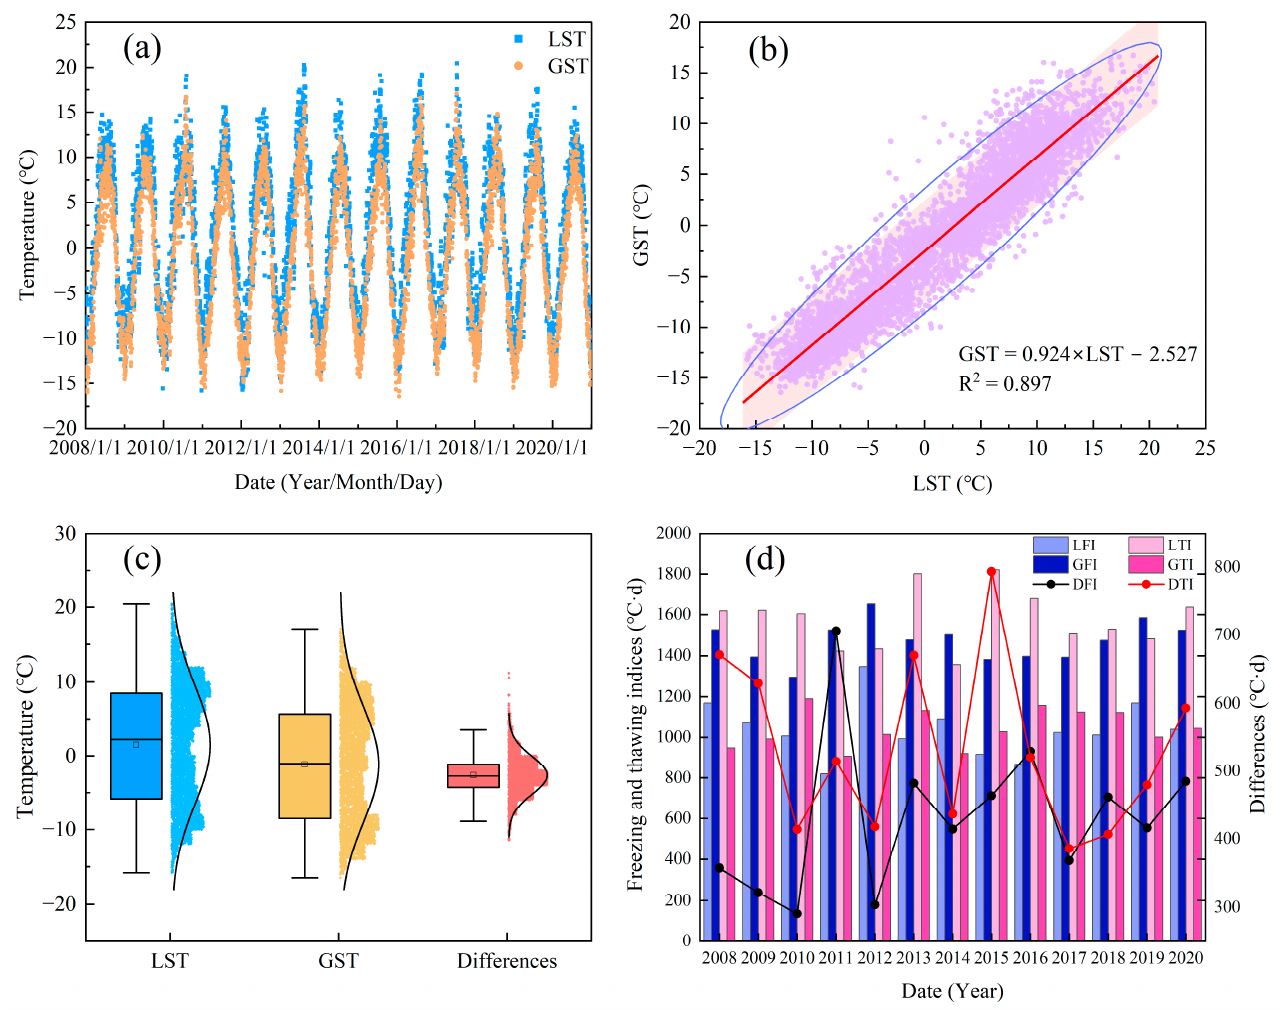
Figure 2. Relationship and differences between land-surface and ground-surface thermal conditions: ( a ) temporal variation of LST and GST at the Beiluhe weather station from 2008 to 2020; ( b ) correlation analysis of LST and GST; ( c ) distribution and range of differences of LST and GST; ( d ) DFI = differences between GFI and LFI, and DTI = differences between GTI and LTI.